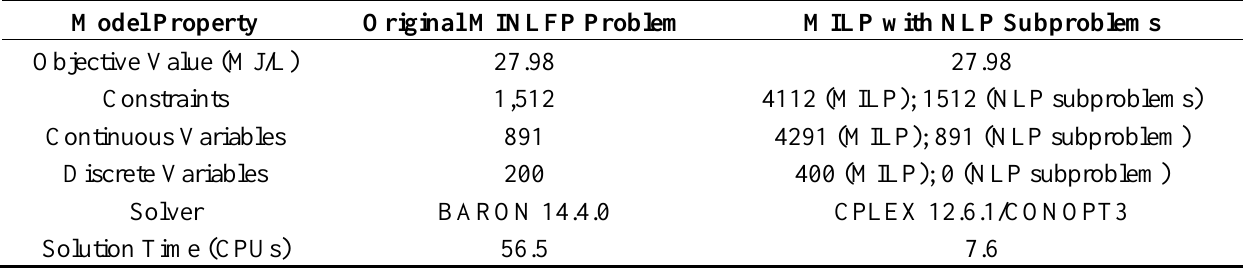
Table A.1. Comparative computational results for calculating the maximum energy efficiency of water solution